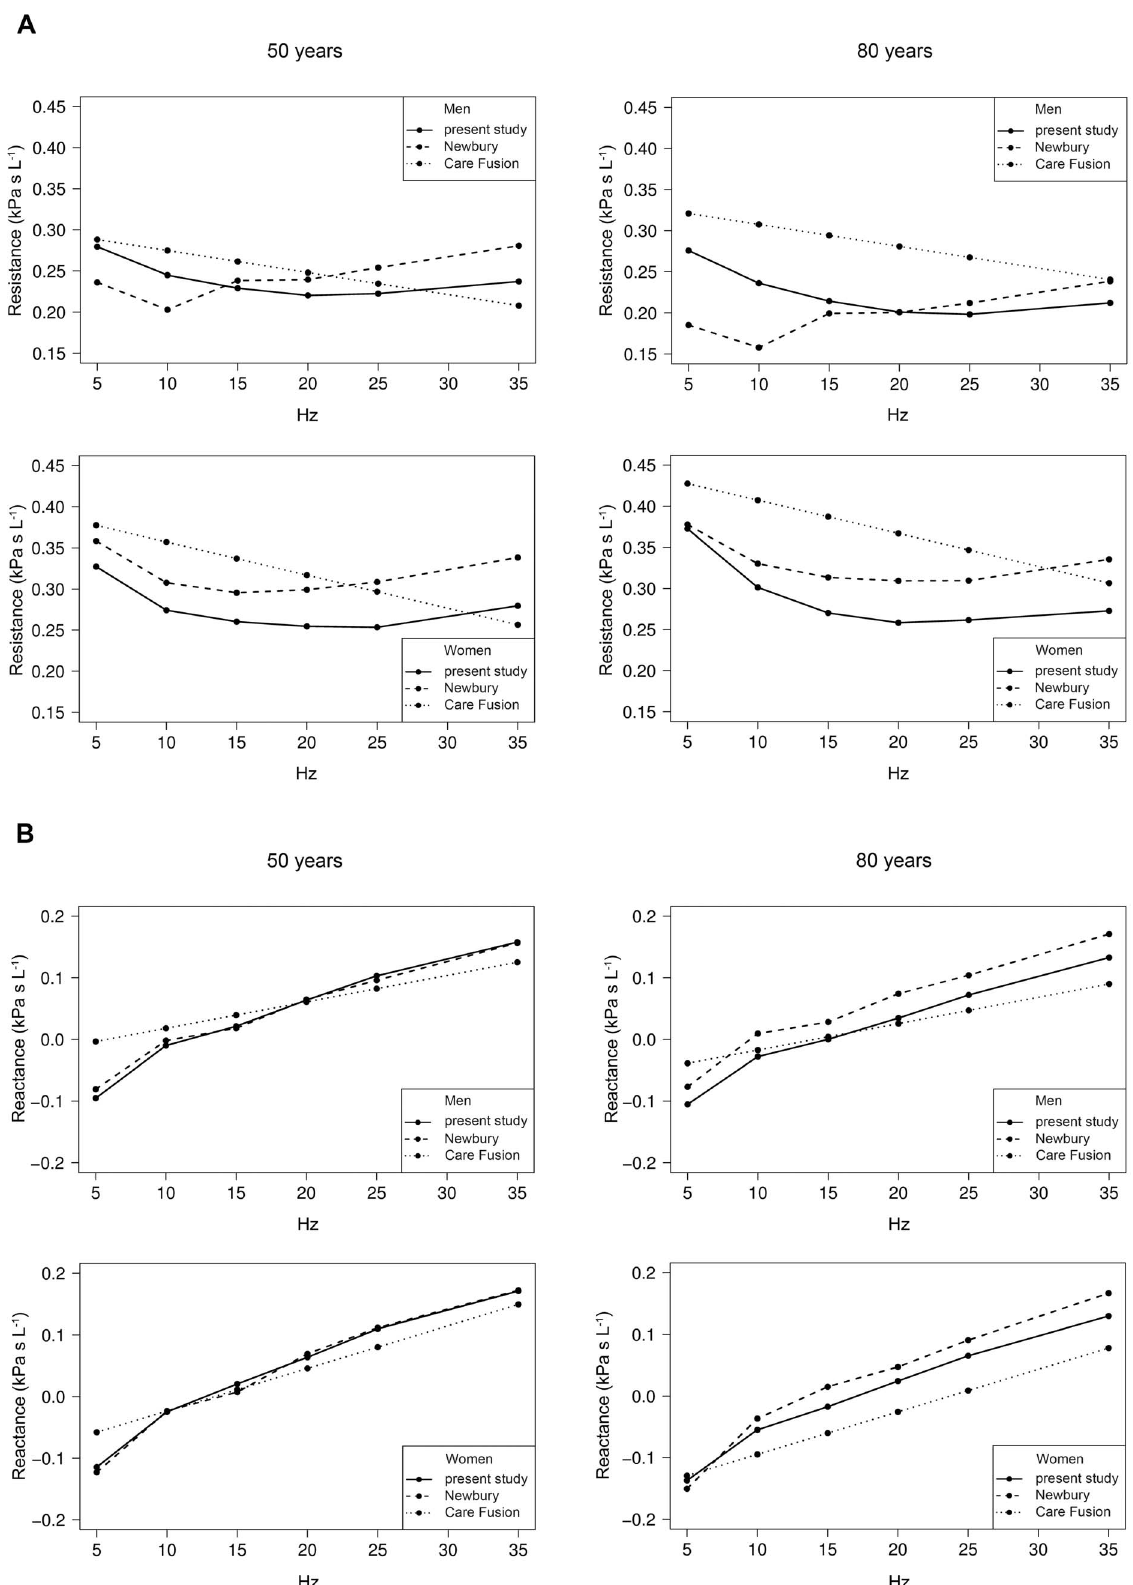
Figure 2. Comparison of values for resistance (A) and reactance (B) for 50 and 80 year old men and women. Calculations are based on equations from Newbury [15] and Vogel & Smidt 1994 (Care Fusion) [2] using median height and weight values from our study population.